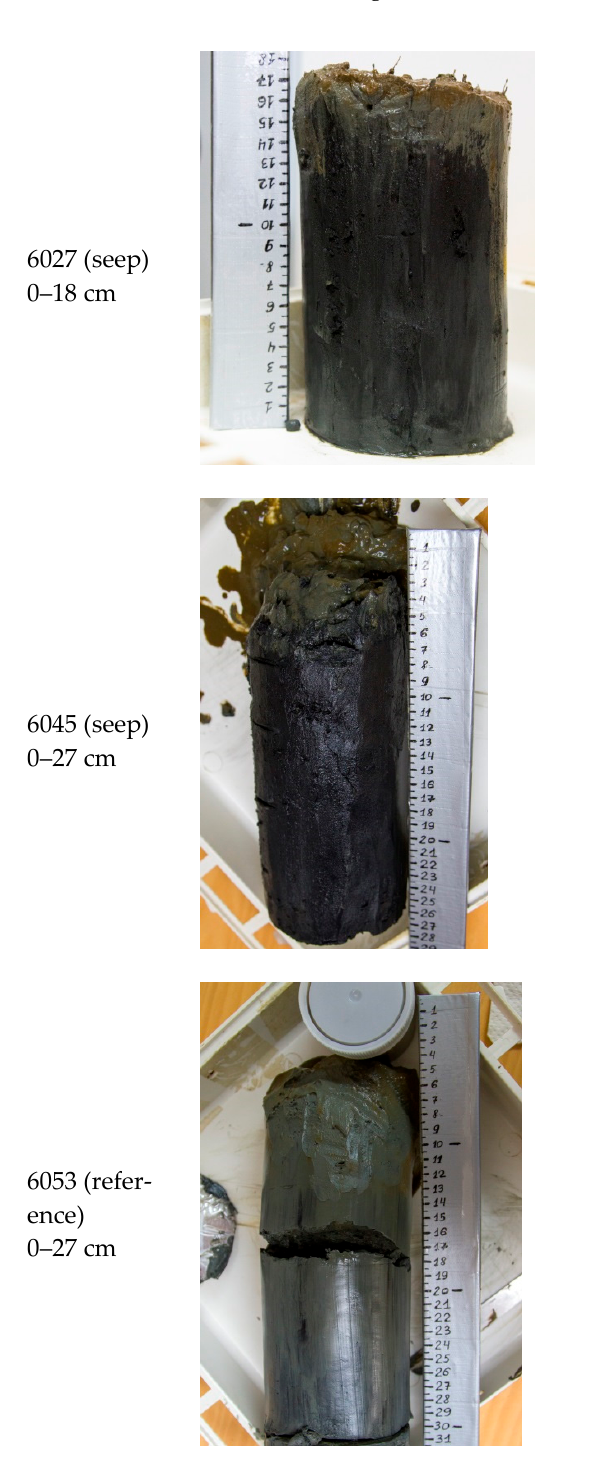
Figure 2. Bottom sediment cores from three stations in the Laptev Sea (73-rd cruise of RV Akademik Mstislav Keldysh) .